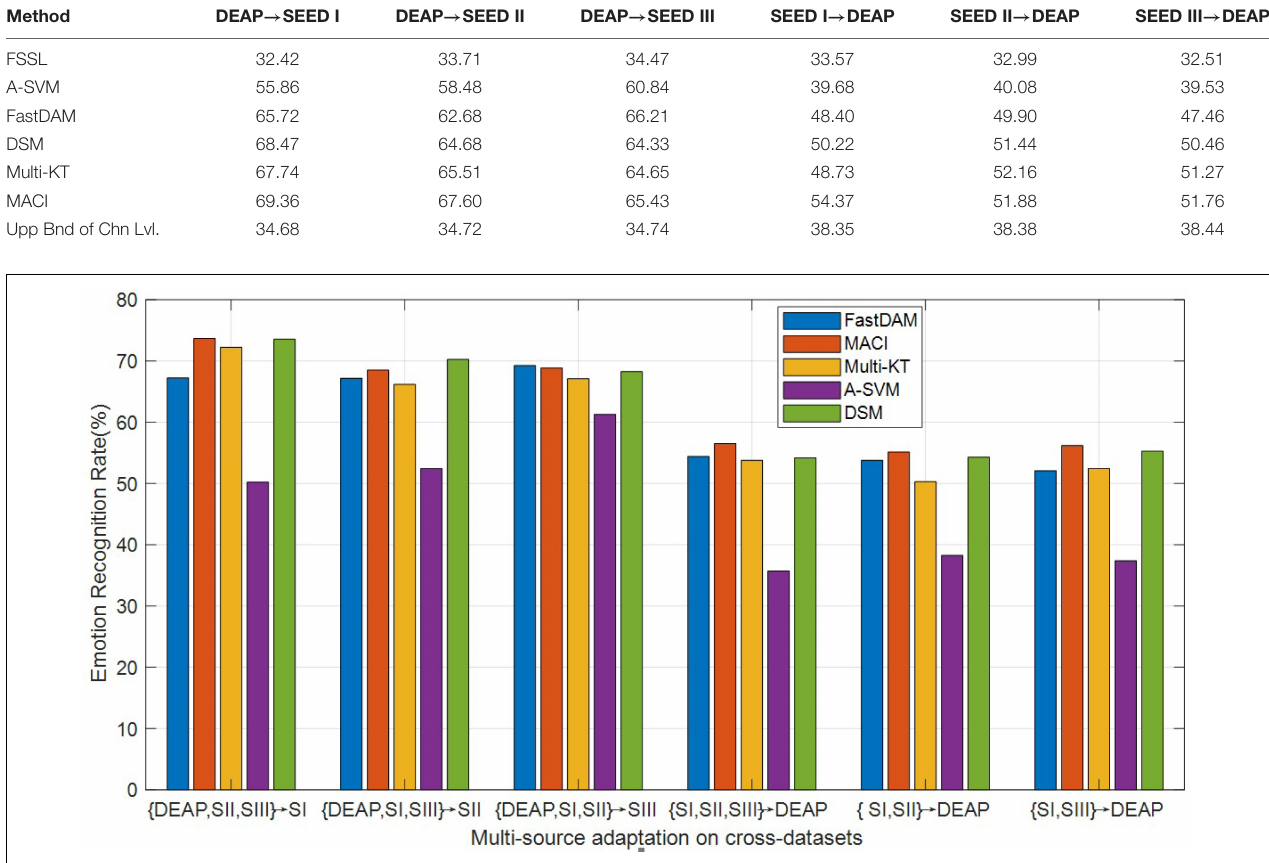
TABLE 3 | The recognition accuracy (mean%) with cross-dataset settings. Method